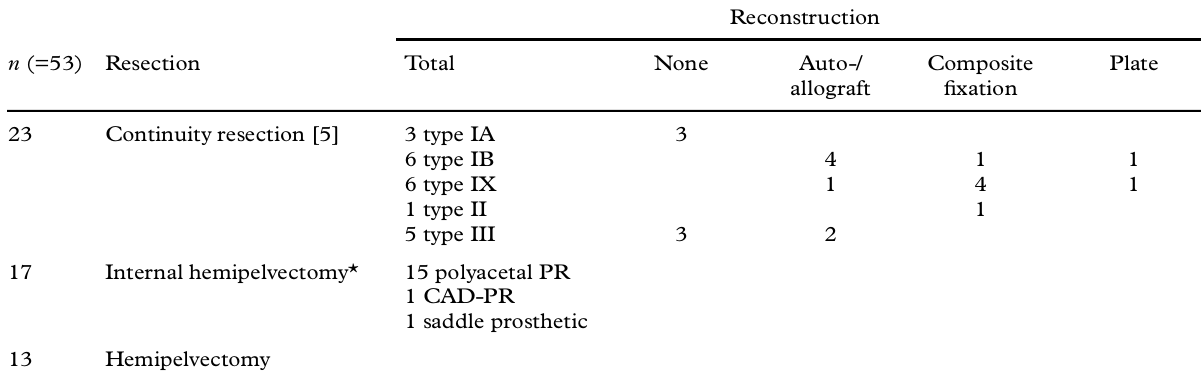
Table 2. Surgical procedures